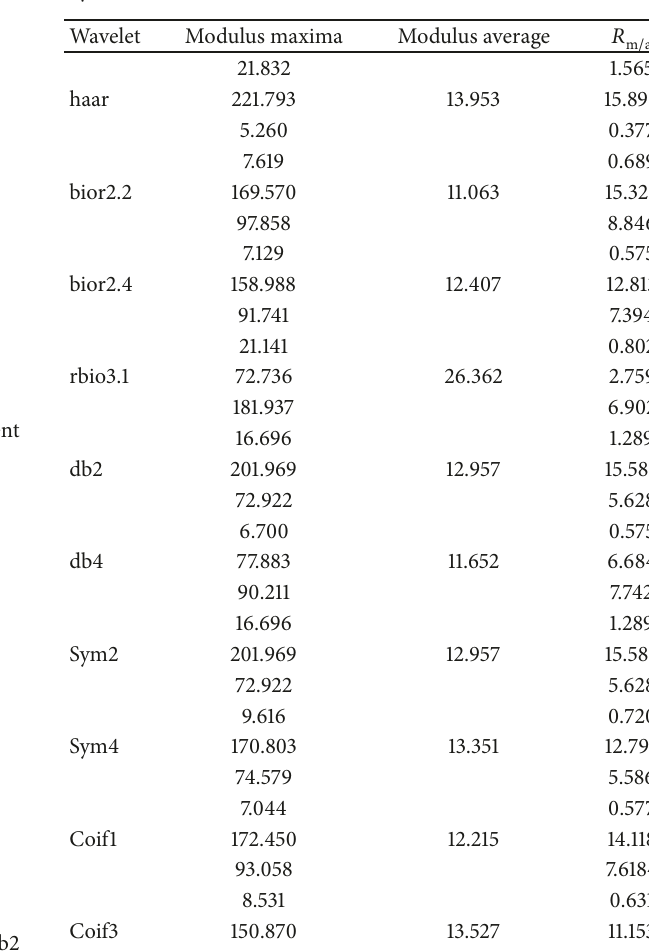
Table 3: 𝑅 𝑚/𝑎 obtained through the detail coefficients of the